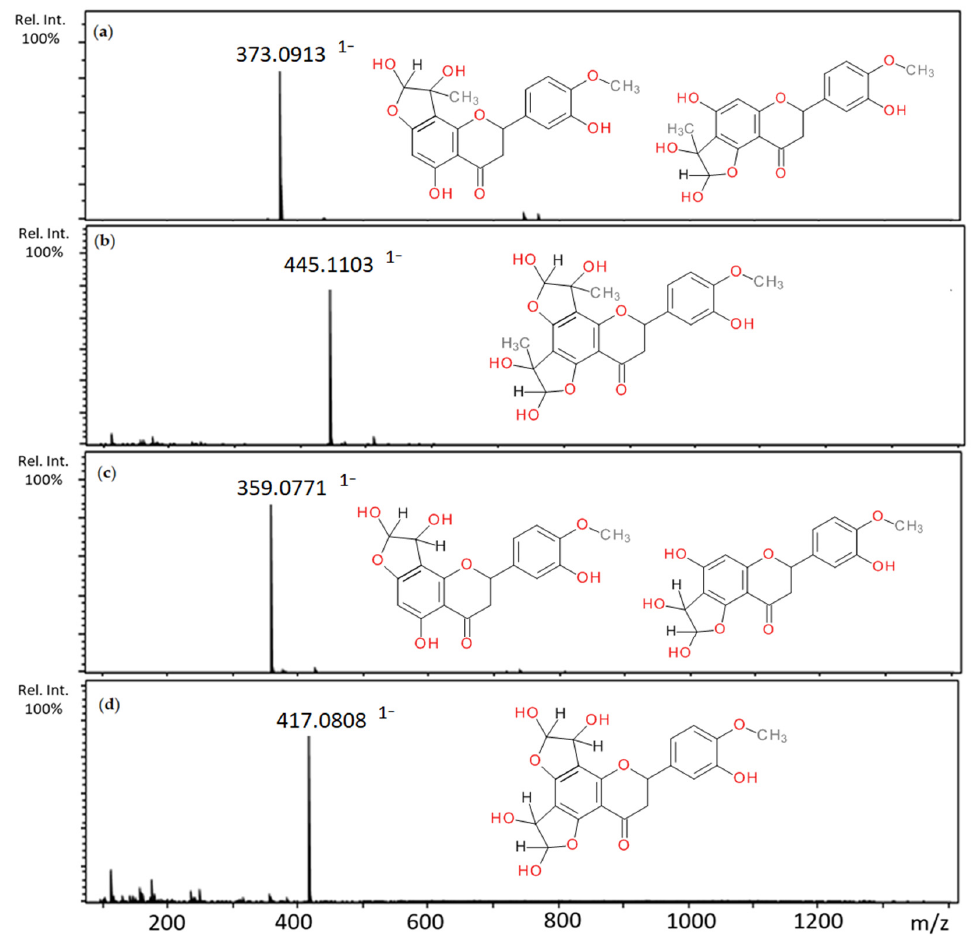
Figure 7. Mass spectra of methylglyoxal and glyoxal adducts with hesperetin after 1 h incubation in pH 7.4 phosphate buffer solution at 37 ◦ C and their proposed chemical structure: ( a ) mono-MGO-hesperetin; ( b ) di-MGO-hesperetin; ( c ) mono-GO-hesperetin; ( d ) di-GO-hesperetin; other isomeric forms are also possible. Quercetin incubated with methylglyoxal resulted in two peaks characterized as mono-MGO-quercetin and one as di-MGO-quercetin; their pseudomolecular ions were at m / z 373 (a–b) for the mono-adducts (quercetin precursor ion m / z 301 increased by 72 Da) and 445 (quercetin precursor ion m / z 301 increased by 144 Da) for the di-adduct (Table 2).